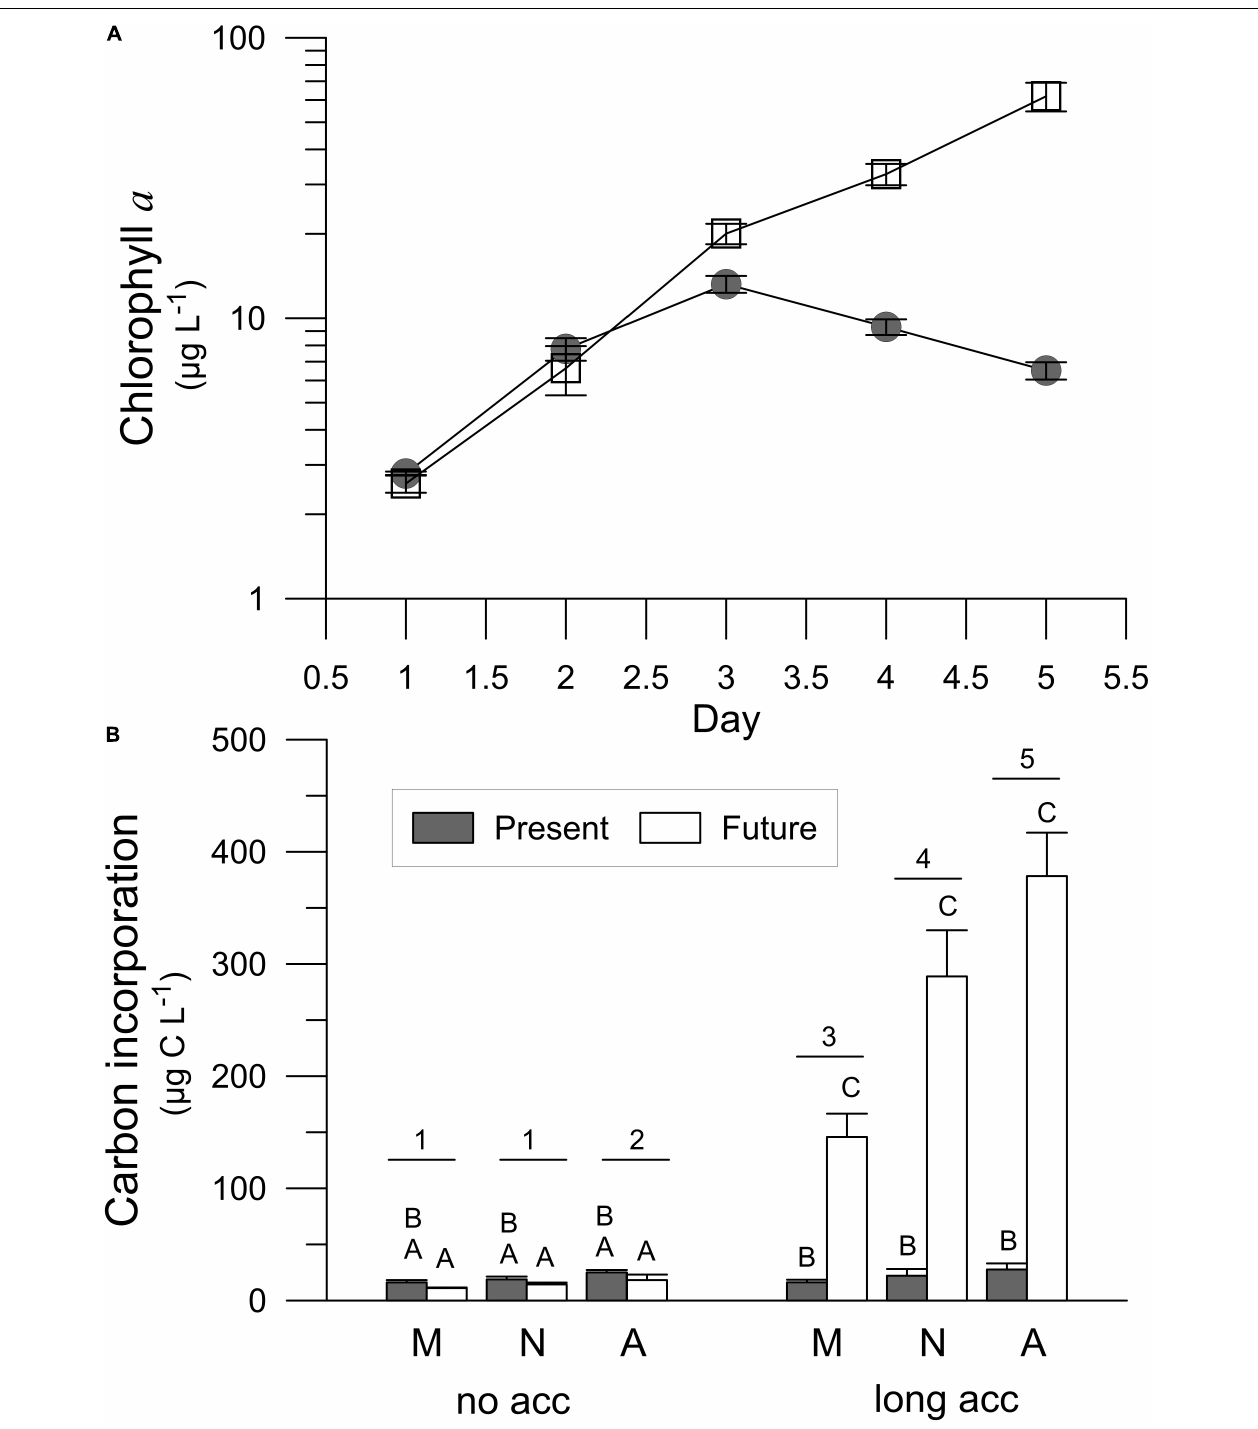
FIGURE 7 | Chlorophyll a concentration (A) and carbon incorporation (B) during the long-term experiment performed with samples collected in Playa Unión (PU) and exposed to the Present and Future scenarios. Capital letters indicate the post-hoc results for the interaction acclimation × scenario, and the numbers indicate the post-hoc results for the interaction time × acclimation (2-way RM-ANOVA). Lines on the top of the bars indicate standard deviation.